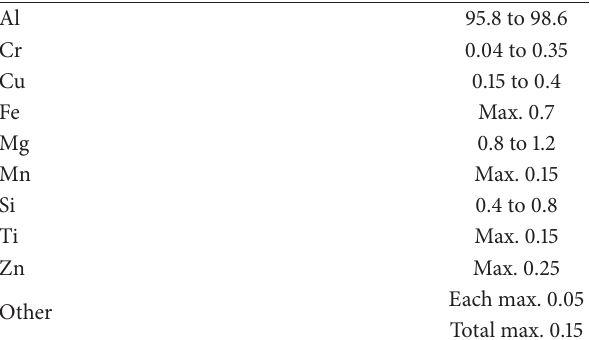
Table 1: Chemical composition in weight of aluminum alloy AISI